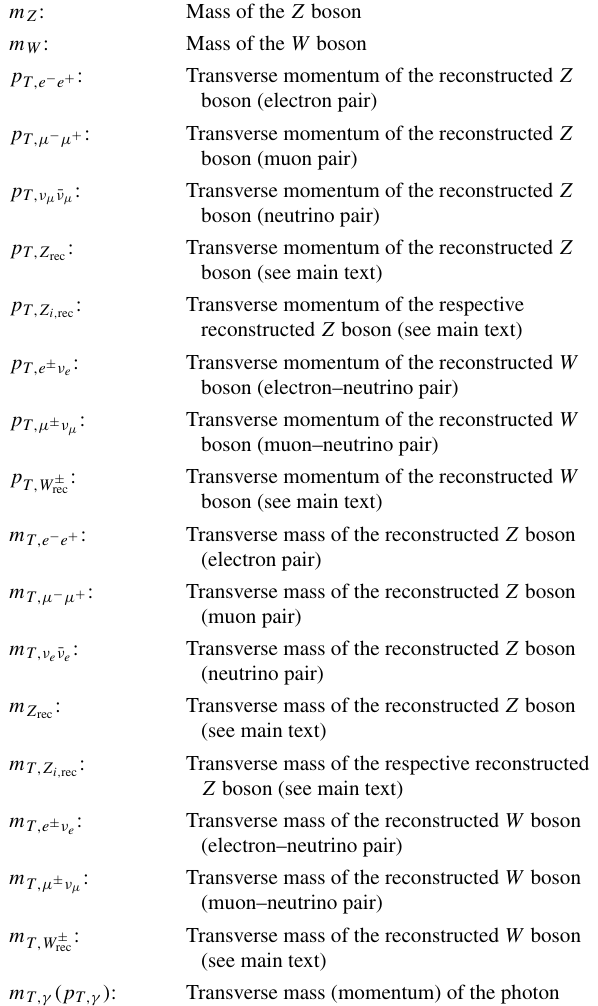
Transverse mass of the reconstructed Z boson (muon pair) Transverse mass of the reconstructed Z boson (neutrino pair) Transverse mass of the reconstructed Z boson (see main text) Transverse mass of the respective reconstructed Z boson (see main